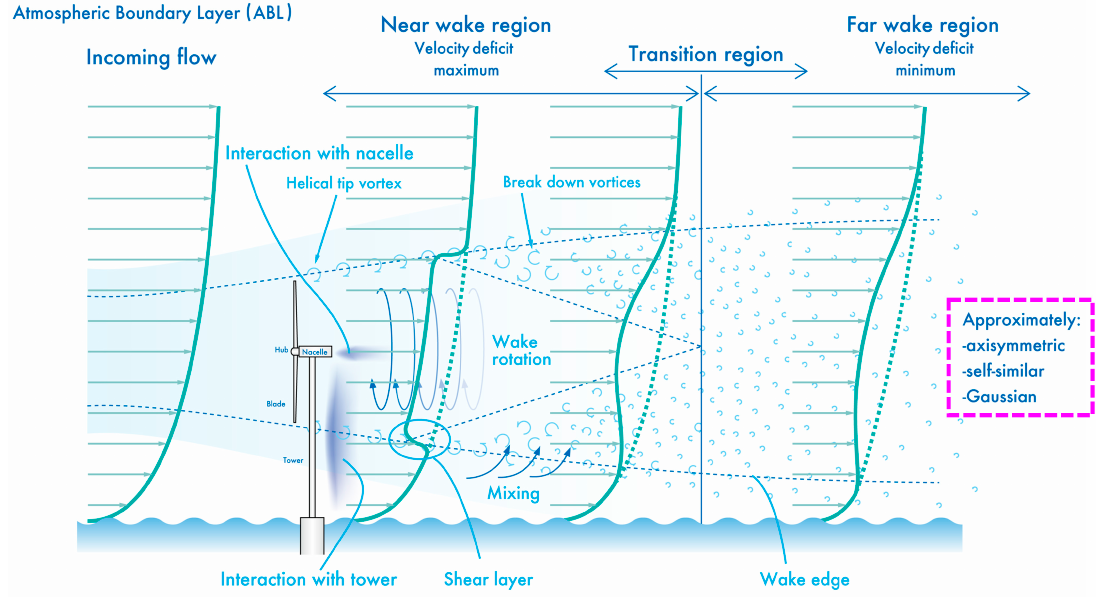
Figure 1. Schematic side view of the wake structure behind a wind turbine.